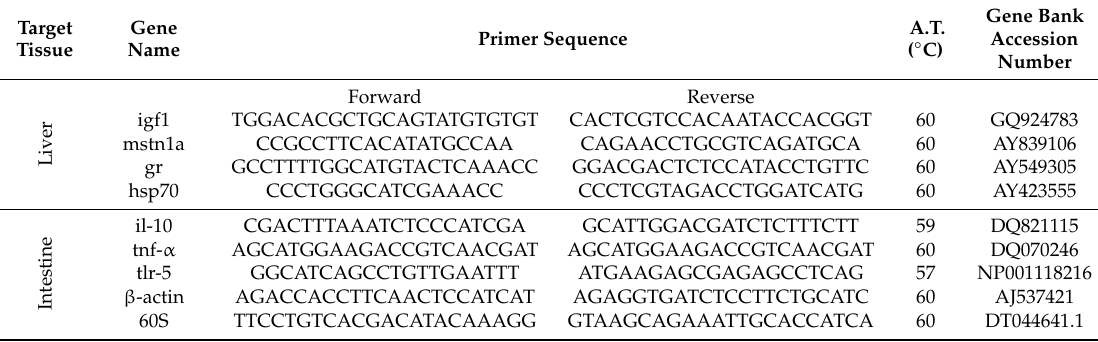
Table 2. Oligonucleotide primers and Annealing Temperature (A.T.) of each gene investigated in this